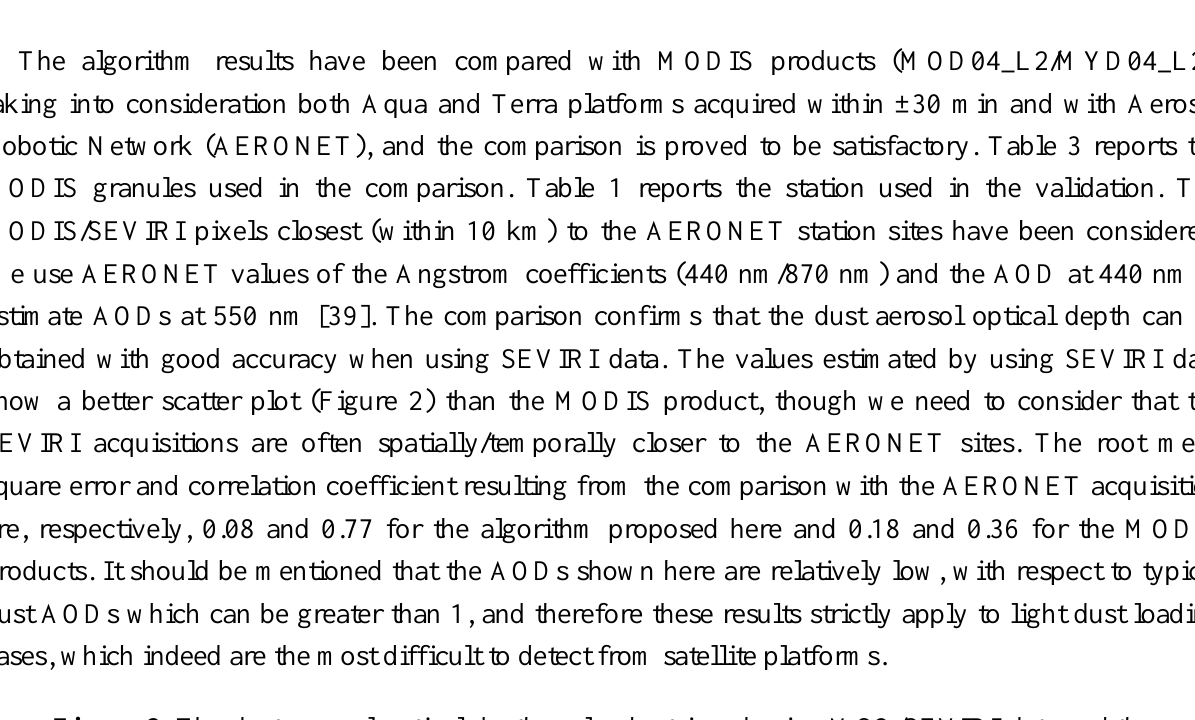
Figure 2. The dust aerosol optical depth on land retrieved using MSG/SEVIRI data and the MODIS (MYD04/MOD04) products compared to AERONET data. Statistics of the comparison are listed in the figure. In particular we report the number of the pixels considered (N), the root mean square error (RMSE), the bias and the correlation